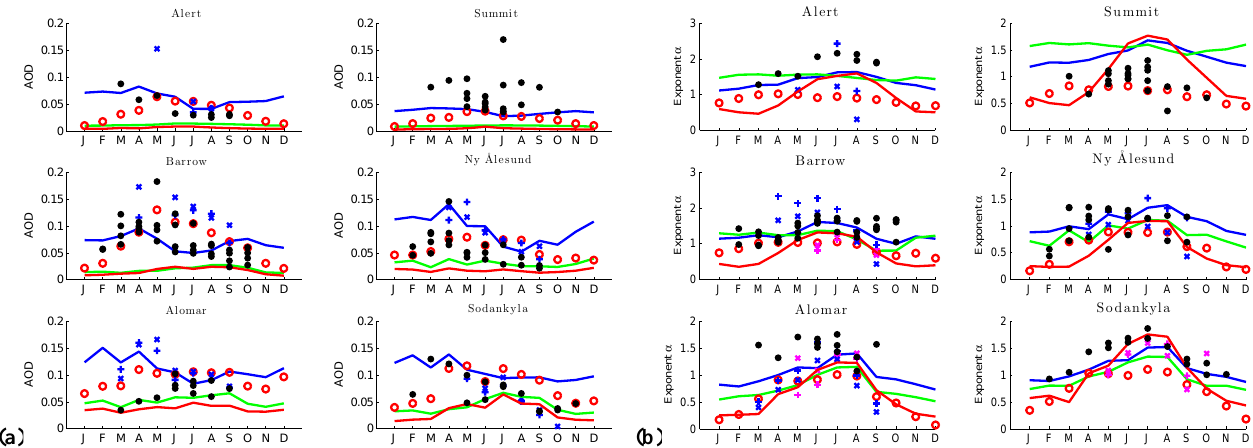
Fig. 4. Observed and modeled seasonal climatologies of AOD at 550nm (panel (a) ) and of the ˚Angstr¨om parameter (panel (b) ) at the mea- surement sites. Observations are shown as black dots (to illustrate interannual variability, we report the individual values for each year). Model results are represented by the continuous lines: ECHAM5-HAM (EIPCC emissions) (green), ECHAM5-HAM with the correction suggested by Bourgeois and Bey (2011) (blue), TM5 (red). MACC data are shown for comparison (red circles) together with MODIS-Aqua (+) and MODIS-Terra (x) observations. For the ˚Angstr¨om parameter both the land (magenta) and the ocean (blue) MODIS products are re- ported. All model data and MODIS-Terra observations (where available) are averaged over the years 2001–2006. MODIS-Aqua observations are averaged over the years 2002–2007 and MACC data are averaged over the years 2003–2006. The station data for AOD were measured at 500nm and interpolated to 550nm using the observed ˚Angstr¨om parameters.